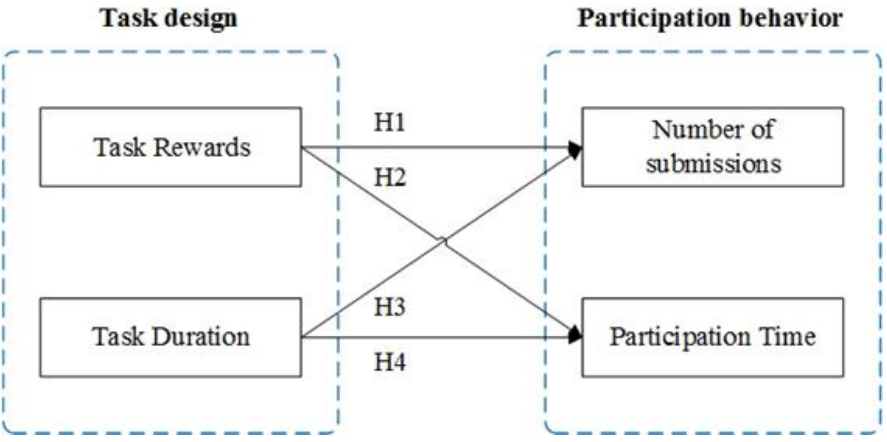
Figure 2. The influence mechanism of task design on solvers’ participation behavior. Source: this figure was created by the